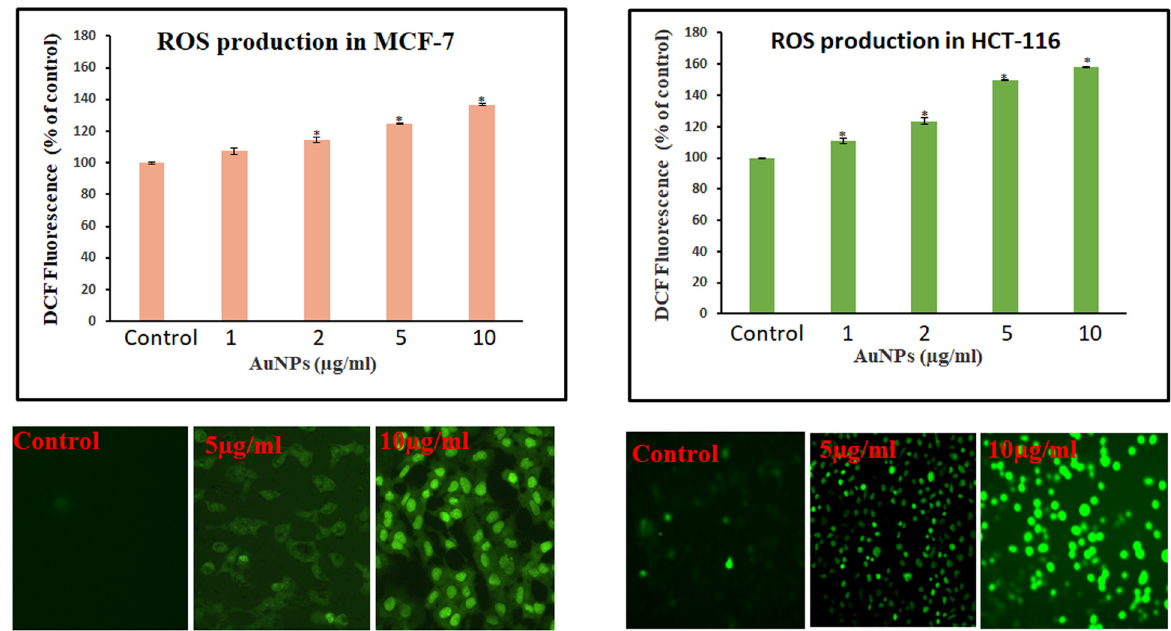
Figure 6: ROS production in MCF - 7 and HCT - 116 cells treated with AuNPs. A spectro fl uorometer was used to detect the relative fl uorescence of DCF, with excitation and emission spectra of 485 and 530 nm, respectively. Student t - test was performed to determine the signi fi cance. Values < 0.05 were considered signi fi cant and indicated with * mark above the column. A Leica microscope ( 20 × magni fi cation ) was used to take the image of the fl uorescing cells.